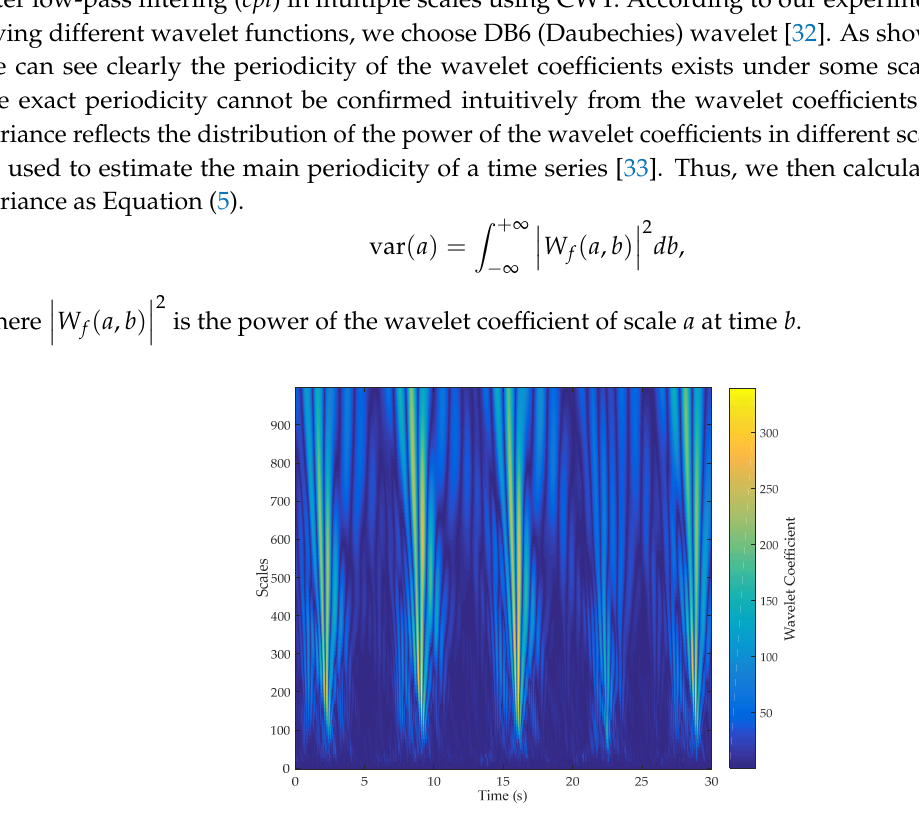
Figure 3. Wavelet variance.